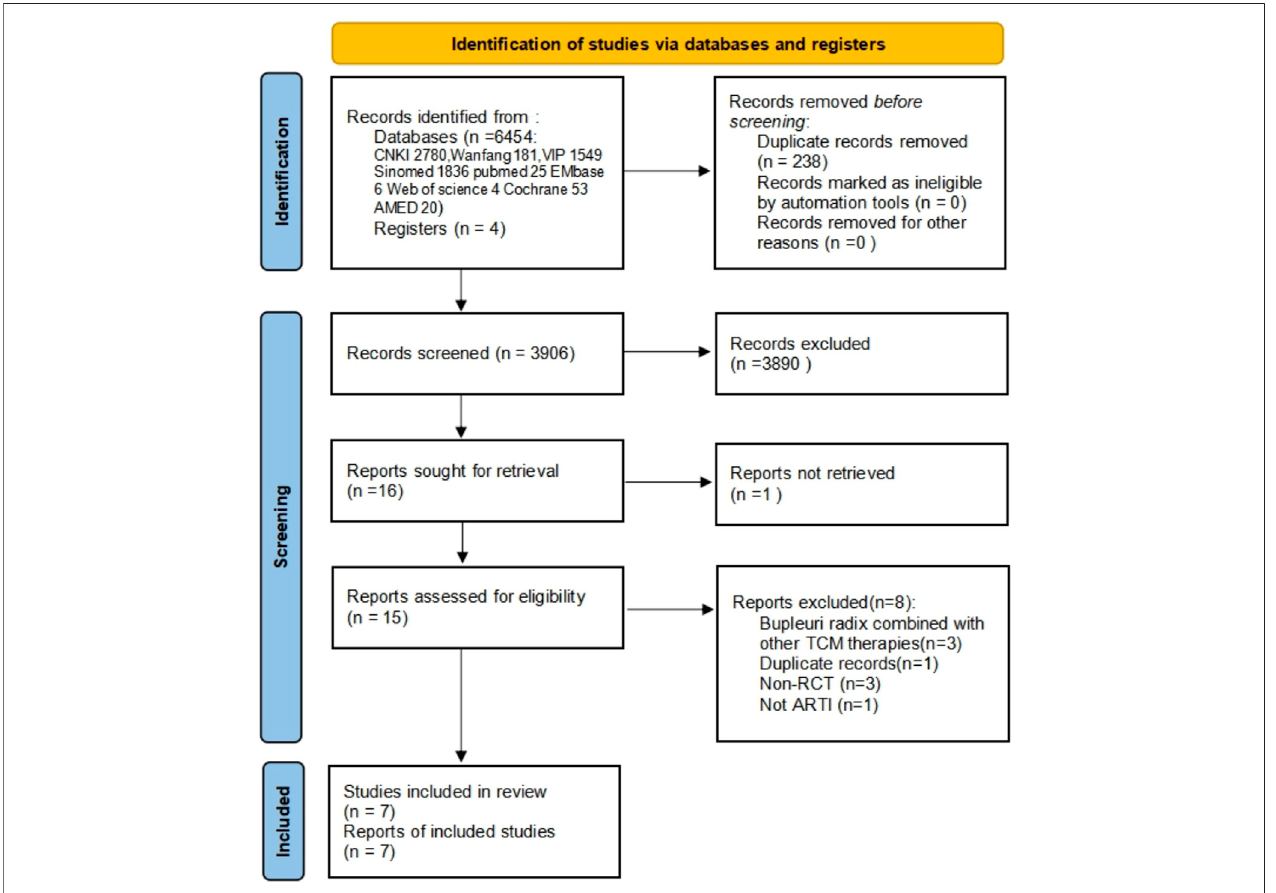
FIGURE 1 | Flow and identi fi cation of trials included. CNKI: China national knowledge infrastructure; VIP: Chinese Scienti fi c Journal Database; AMED: The Allied and Complementary Medicine Database; CBM: Chinese Bio Medical Literature Database; ARTI: Acute uncomplicated respiratory tract infections; RCT: randomized controlled